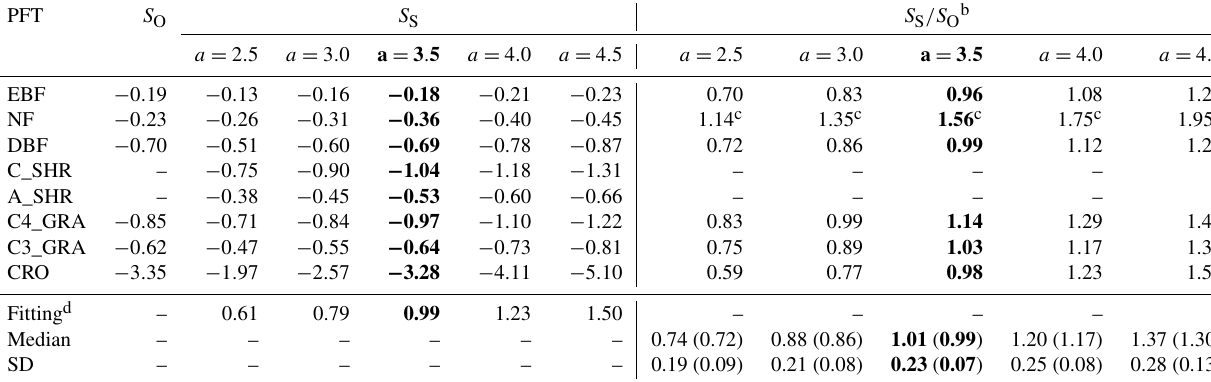
Table 2. Calibrations of the YIBs-LMA a experiment with varied a